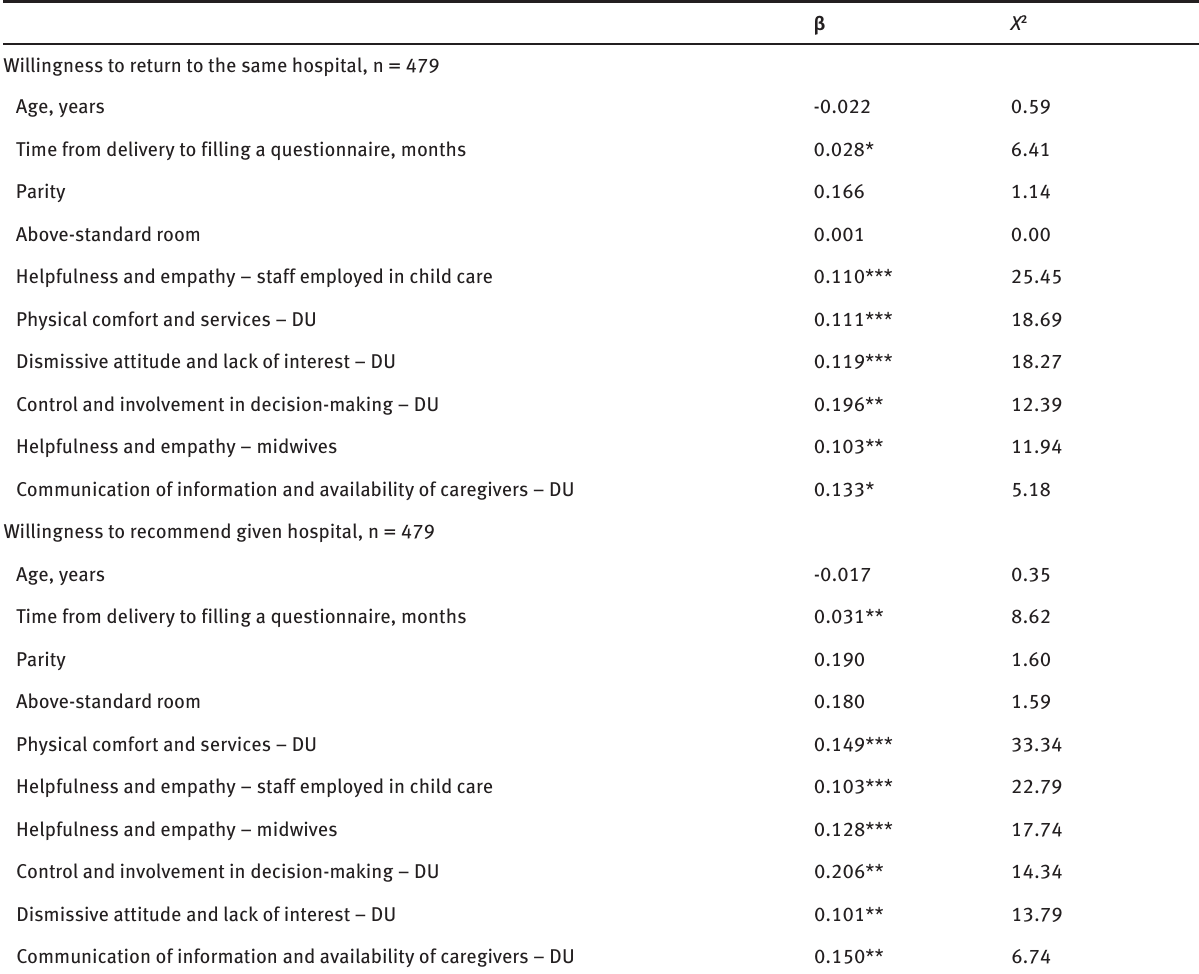
Table 3 : Predictors of willingness to return to the same hospital and to recommend this hospital (model 3, model 4).